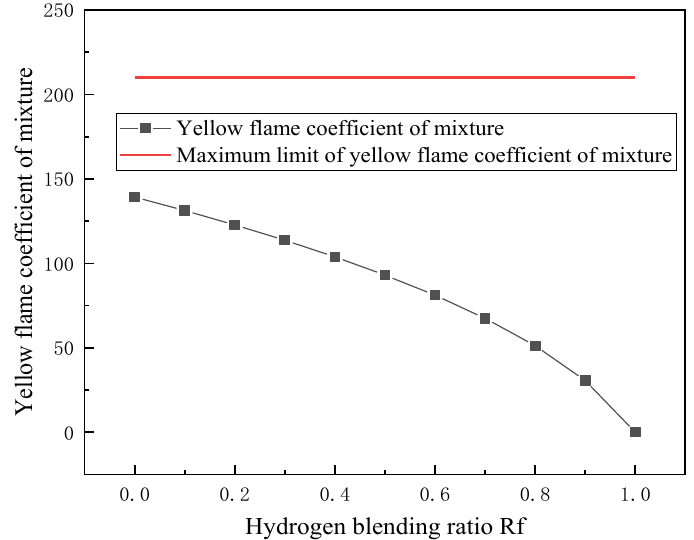
Figure 6. Calculation of high calorific value of mixture.